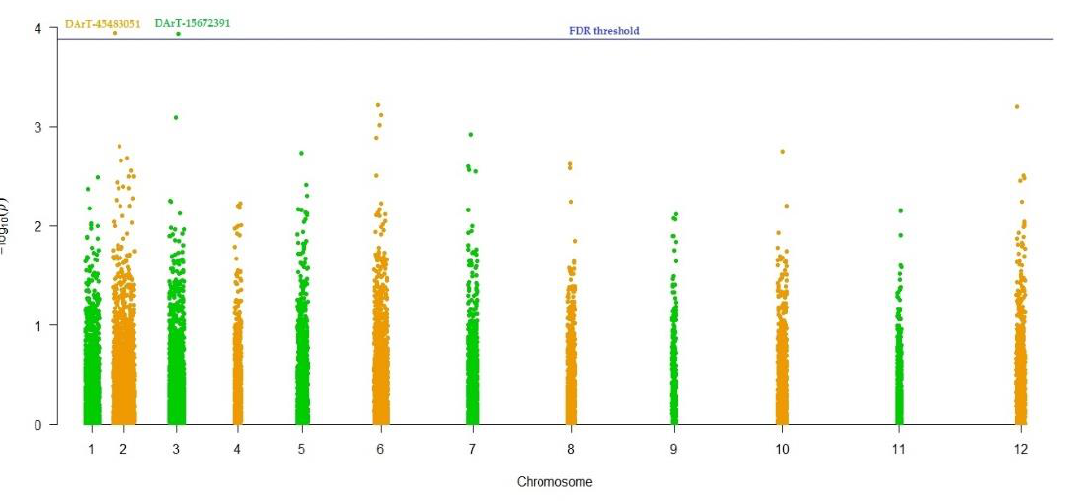
Figure 8. Principal coordinate analysis (PCoA) of the 94 safflower accessions using silicoDArT molecular markers.